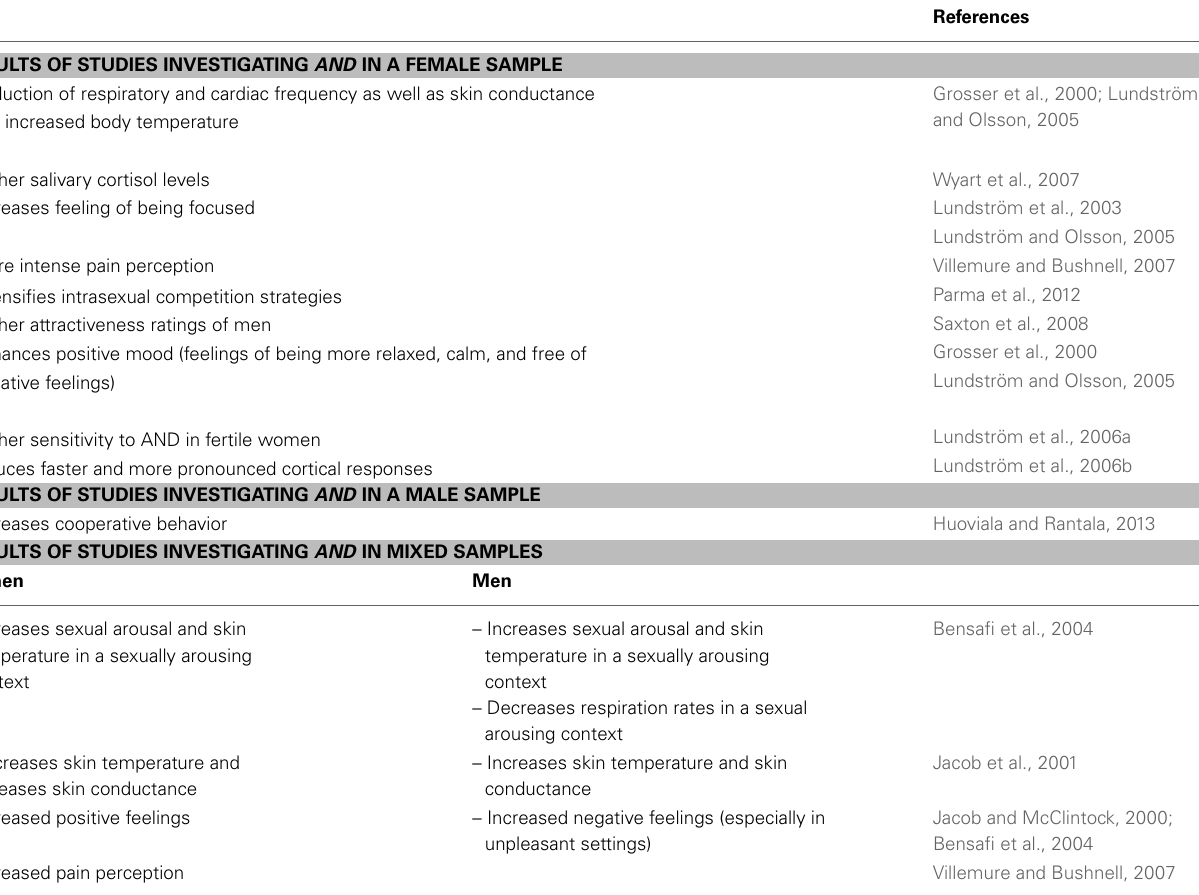
Table 1 | Behavioral and psychophysiological results induced by AND